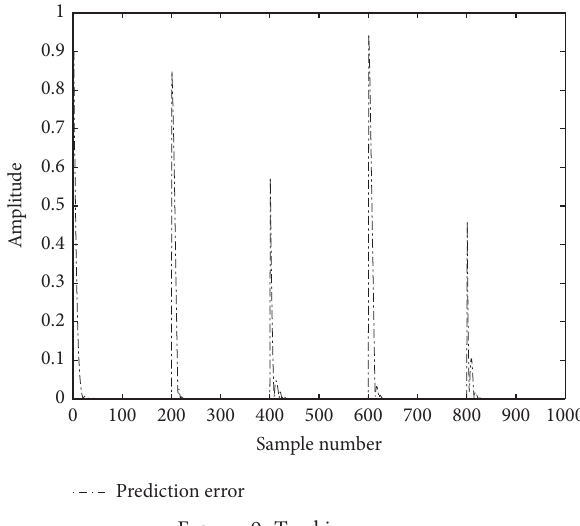
Figure 9: Tracking